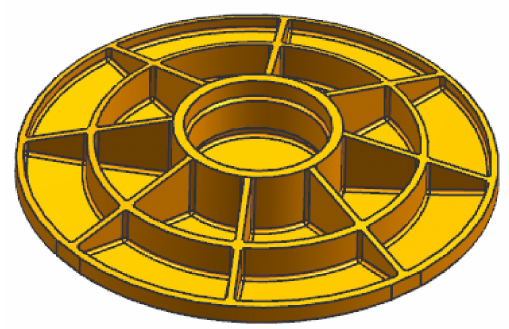
Figure 3. The mirror